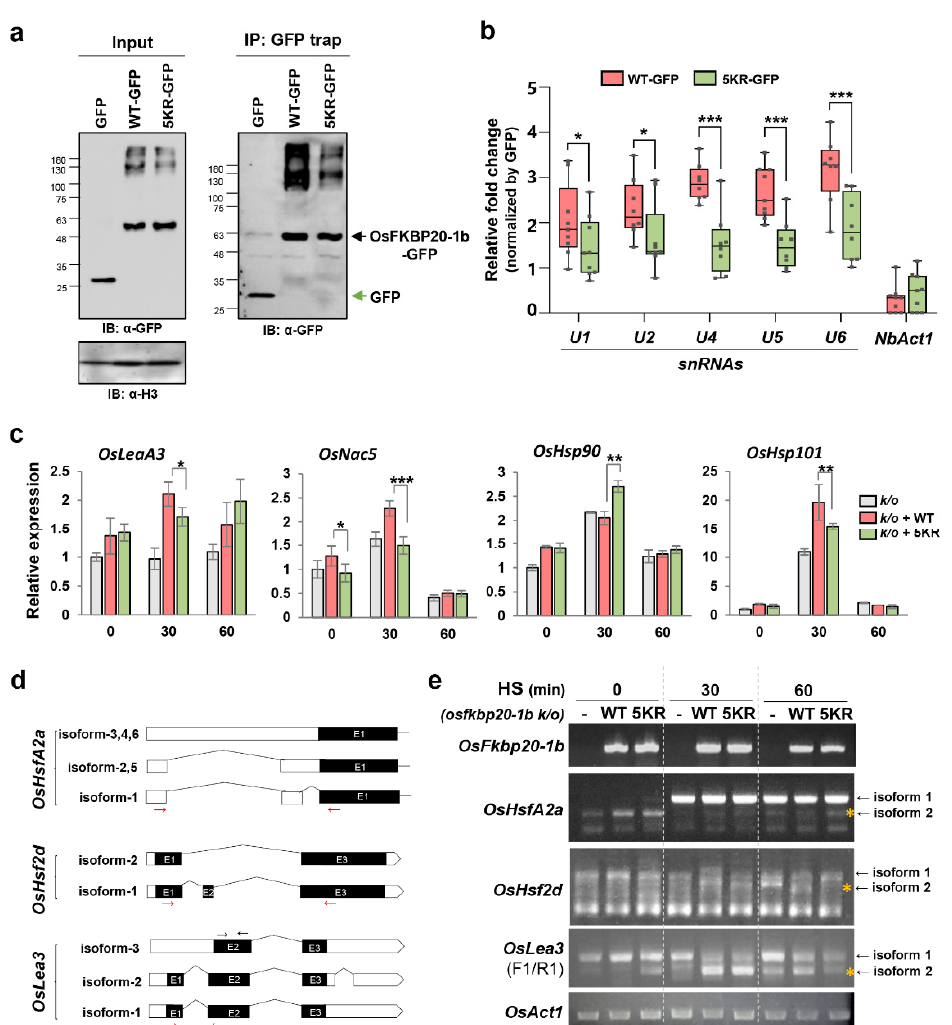
Figure 6. snRNAs and transcription level of stress responsive genes in association with either WT_OsFKBP20-1b or 5KR_OsFKBP20-1b. ( a , b ) GFP fused OsFKBP20-1b WT and OsFKBP20-1b 5KR mutant constructs were transiently expressed in leaves of N. benthamiana using A. tumefaciens infiltration. ( a ) GFP fused proteins were extracted from the leaves and these proteins were purified by immunoprecipitation (IP) using a GFP trap. HistoneH3 antibody used for nuclear protein loading control. ( b ) RNA immunoprecipitation (RIP) assay. NbSnRNAs ( U1 , U2 , U4 , U5 , and U6 ) and NbActin ( NbAct1 ) were detected by RT-qPCR. The value of GFP fused to OsFKBP20-1b WT and 5KR was normalized by GFP control. Bars represent SEM of nine biological replicates. Student’s t -test; * p < 0.1, ** p < 0.05, *** p < 0.005. ( c – e ) Protoplasts were isolated from the shoots of osfkbp20-1b k/o seedlings, and WT_ and 5KR_OsFKBP20-1b proteins were transiently expressed by PEG mediated transfection assay. Total RNA was isolated at 22 h (0 min) after protoplast transfection and 30–60 min after heat stress treatment. ( c ) Transcript expression levels of abiotic stress-responsive genes ( OsLea3 and OsNac5 ) and heat stress-responsive genes ( OsHsp90 and OsHsp101 ). Transcripts were detected using semi-quantitative RT-PCR analysis. OsAct1 was used as the normal control. Bars represent mean SEM of three biological replicates. Student’s t -test; * p < 0.05, ** p < 0.01. ( d , e ) Semi-quantitative RT-PCR analysis of alternative splicing patterns of stress-responsive genes in mutant seedlings. Alternatively, spliced isoforms of OsHsfA2a , OsHsf2d , and OsLea3 are presented in ( d ). OsAct1 was used as a loading control. Red arrows indicate the primer sites used.